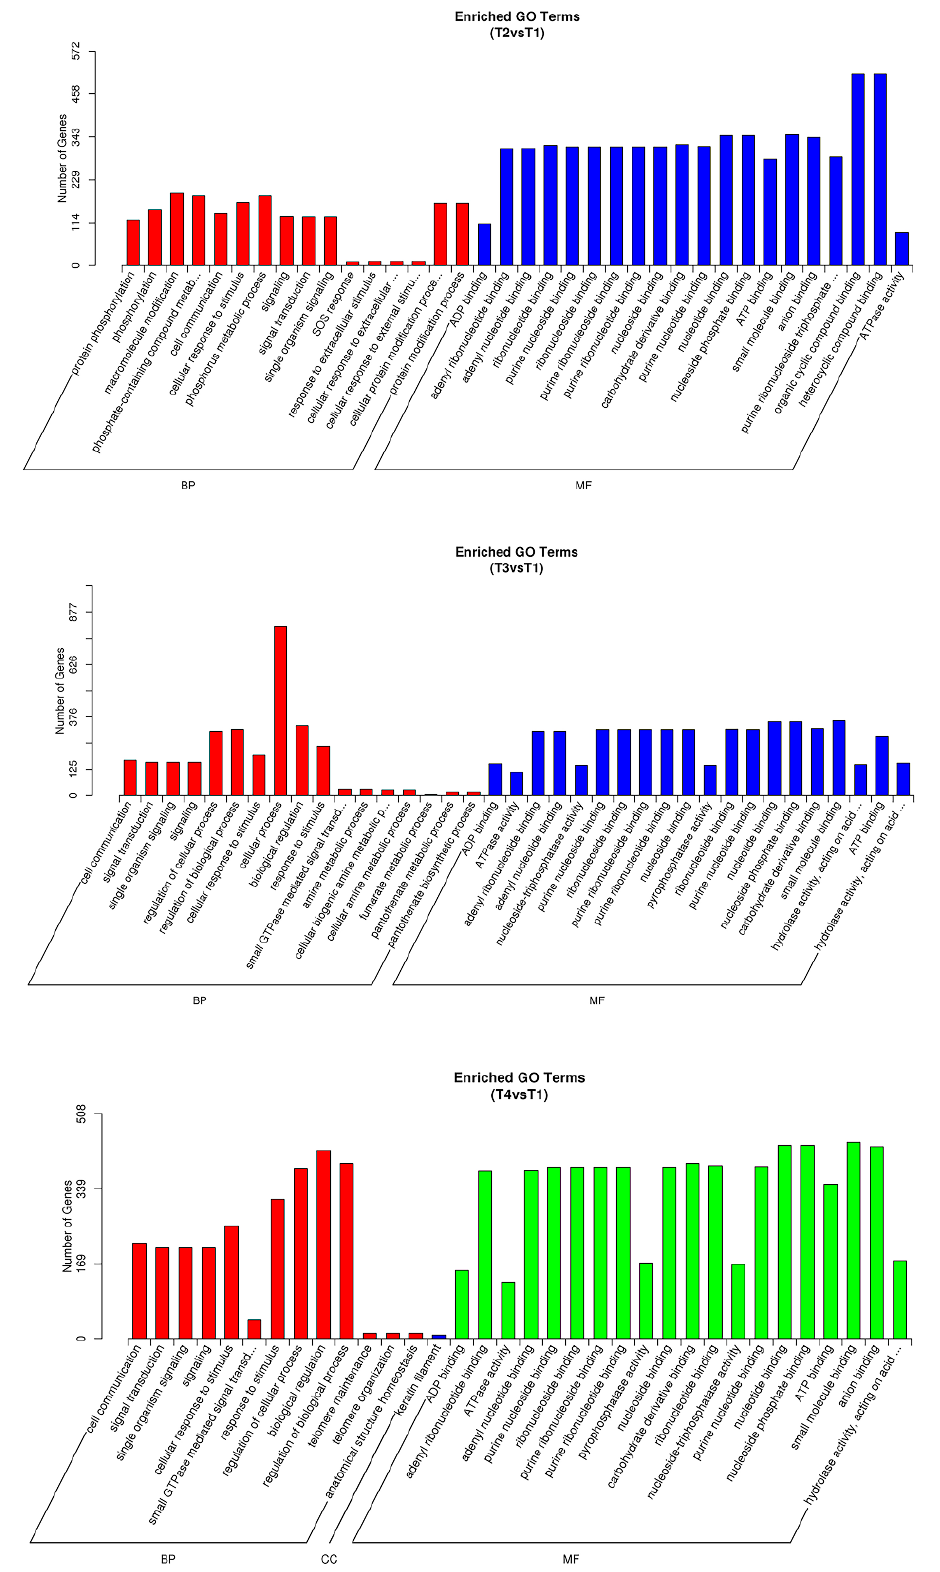
Figure 2. Gene ontology (GO) classifications of putative targets of differentially expressed miRNAs in T. hybrid subjected to salt stress in T2 vs. T1, T3 vs. T1 and T4 vs. T1, respectively. BP—biological process; MF—molecular function; CC—cellular component.